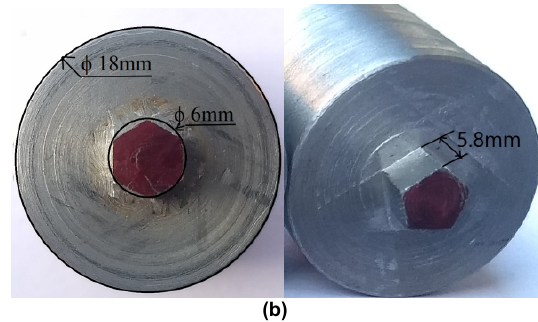
Figure 2. Experiment details: (a) Experiment layout, (b) Tool with flat faced pin K-Type thermocouples (TC1 and TC2) were